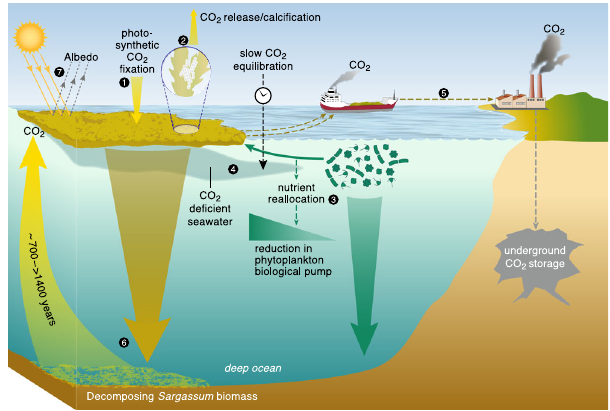
Fig. 4 Summary of feedbacks discussed in this study. The numbers in the black circles denote individual processes in the order they were discussed. 1. Photosynthetic carbon fi xation by Sargassum consumes CO 2 dissolved in seawater. 2. Sargassum provides habitat for epibiontic encrusting organisms to calcify, thereby generating CO 2 through complicated feedbacks in the seawater carbonate system. 3. Nutrients taken up by Sargassum become unavailable for phytoplankton thereby reducing the natural carbon sequestration by phytoplankton. 4. CO 2 de fi cient seawater (driven by photosynthesis) can be subducted below the surface layer before it fully equilibrates with atmospheric CO 2 . 5. Sargassum biomass can be harvested and transported to shore and used for Bioenergy with Carbon Capture and Storage (BECCS) causing CO 2 discounts. 6. Alternatively, Sargassum could be deposited on the sea fl oor but a large fraction of the respired Sargassum carbon would come back to surface on centennial-millenial timescales. 7. Sargassum increases albedo at the sea surface but could also induce complicated indirect albedo effects of unknown sign and